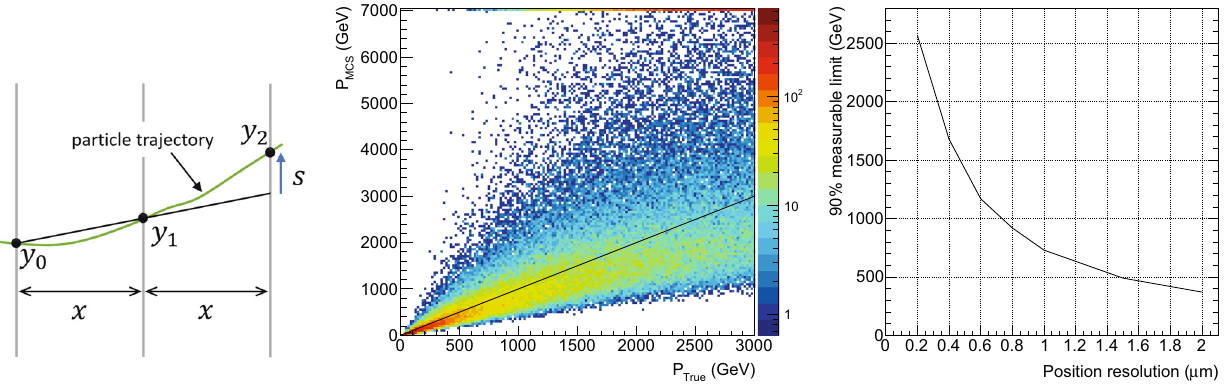
Fig. 9 Left : Vertex detection efficiency after requiring at least 5 charged particles at a neutrino interaction vertex (CC and NC inclusive). Only the statistical uncertainties of the generated Genie samples are shown. Right : The distribution of events in the (τ flight length , kink angle ) -plane, where the events are ν τ CC inter-